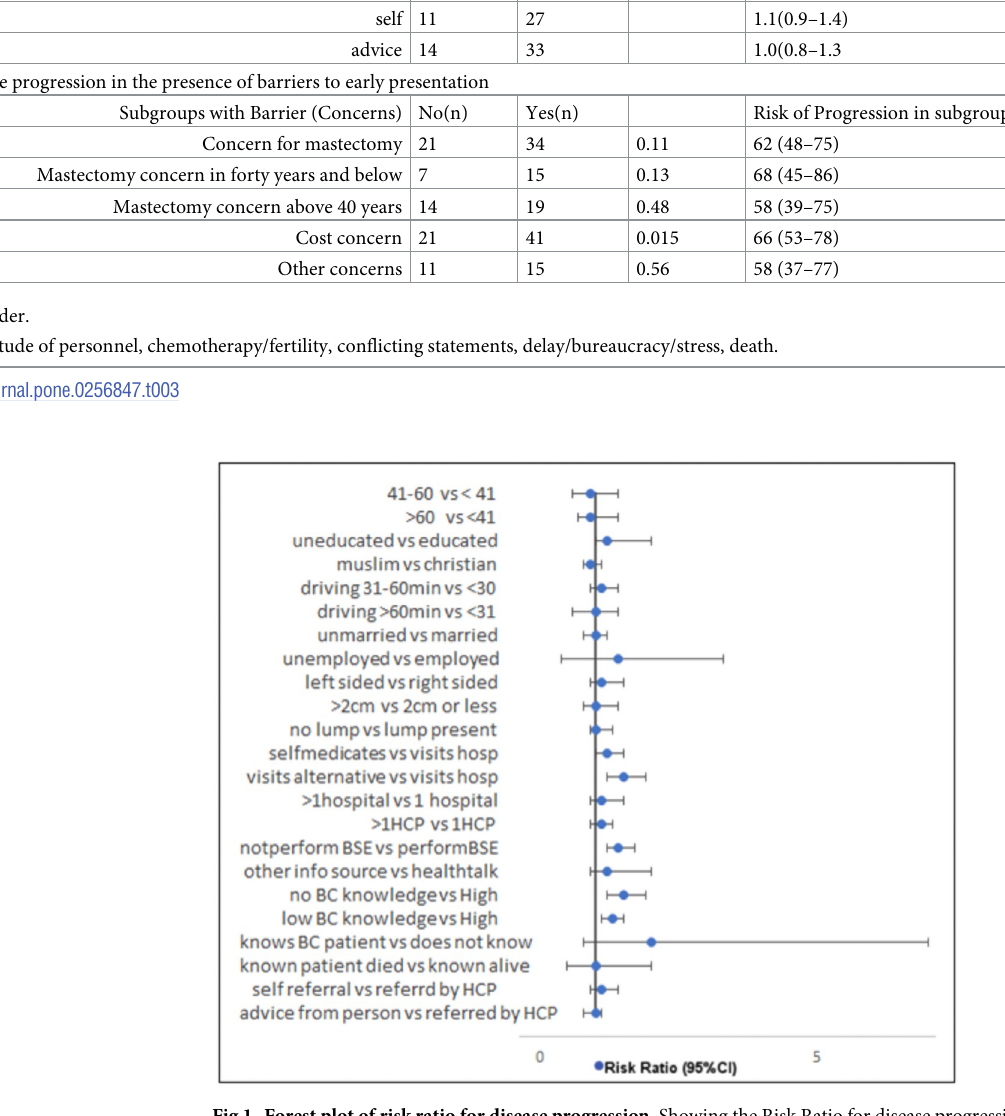
Fig 1. Forest plot of risk ratio for disease progression. Showing the Risk Ratio for disease progression based on demographic, socioeconomic factors, symptomatology premorbid preferences, and knowledge. BC- Breast Cancer, BSE-Breast Self-Examination, HCP-Healthcare Provider, vs = ‘compared